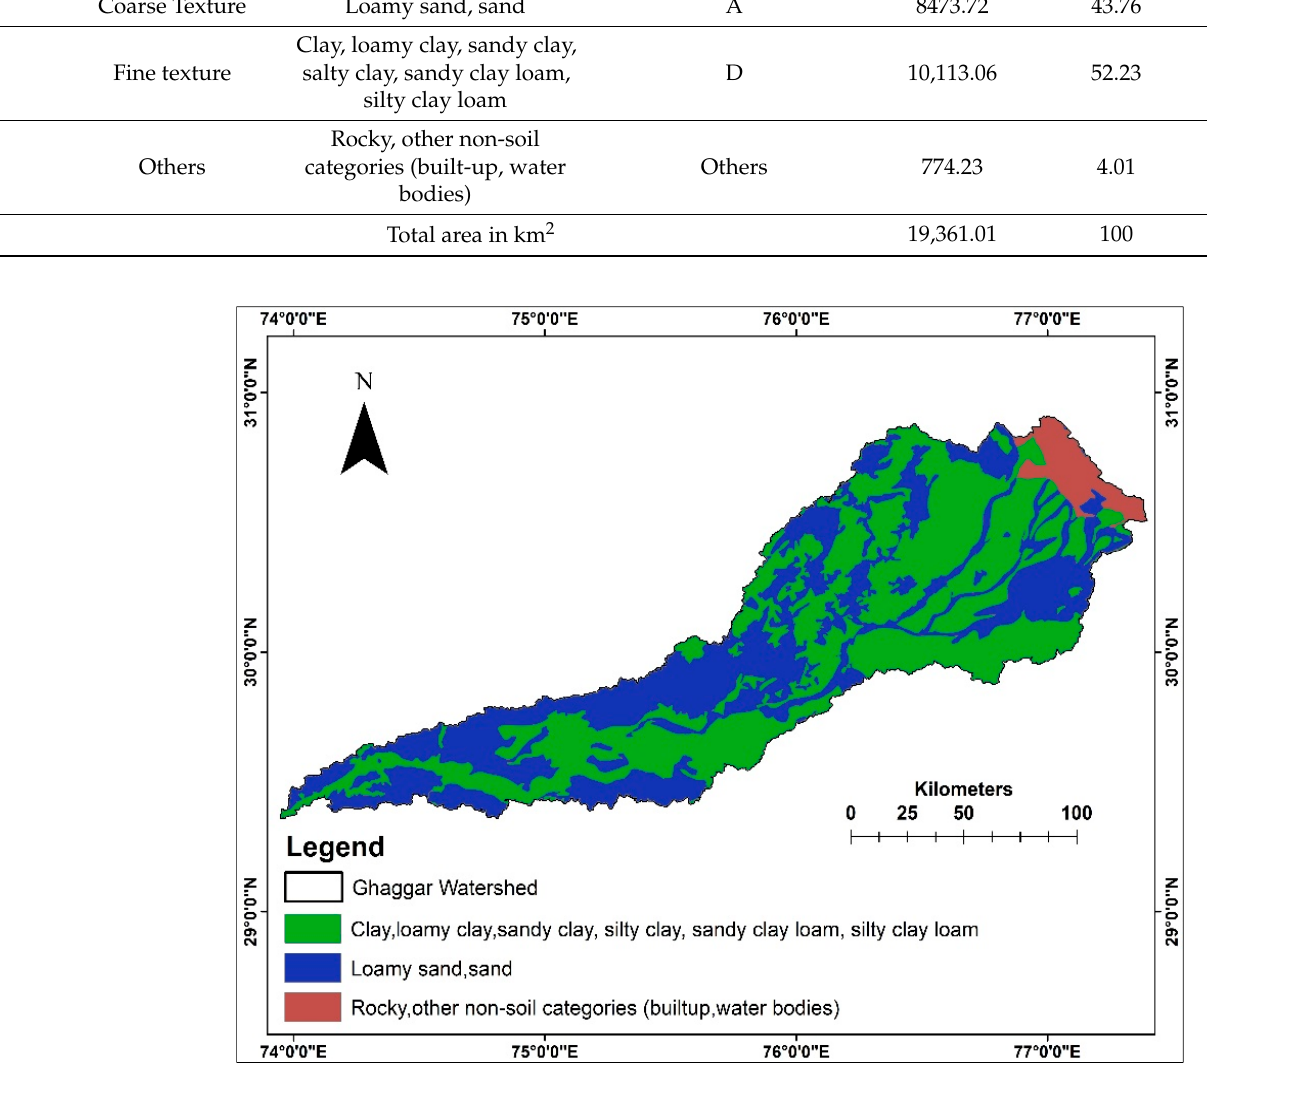
Figure 4. Soil types of study area (Source: National Soil Conservation and Salinization Board).